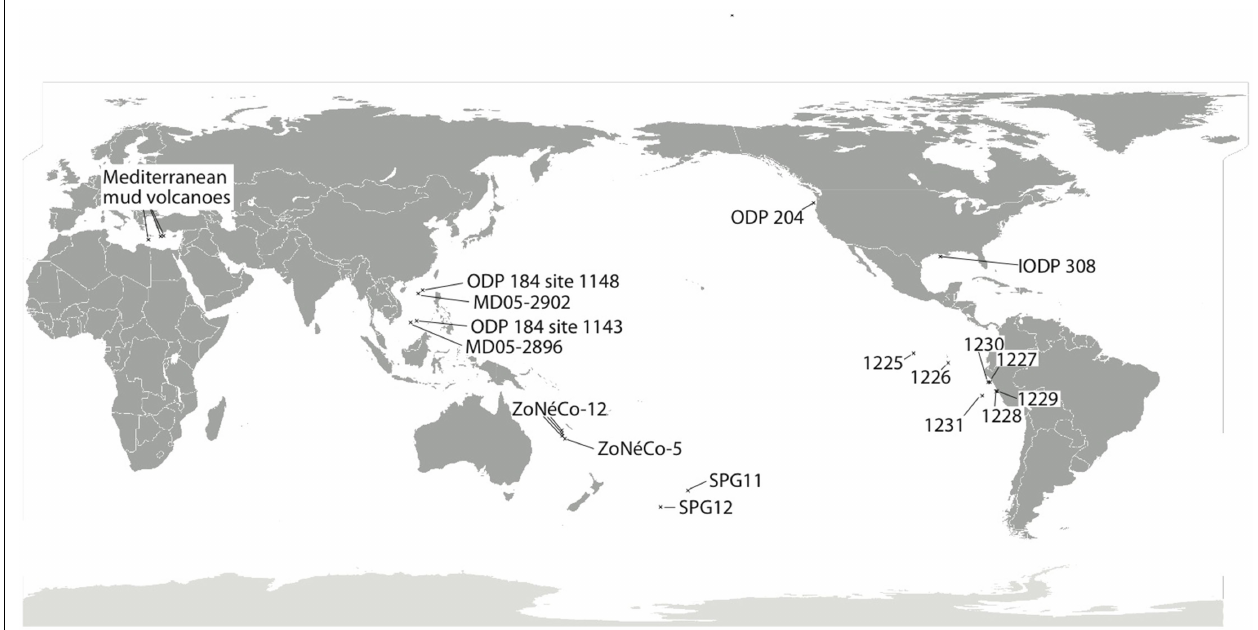
The IODP 308 sites (U1319, U1320) are located in the turbidite depositional Brazos-Trinity Basin on the continental slope of the northern Gulf of Mexico (Nunoura et al., 2009).The ODP Leg 201 Sites (Shipboard Scientific Party, 2003a–f; D’Hondt et al., 2004) include sites from the eastern equatorial upwelling region (1225), South Equatorial Current (1226), Peru Margin (1227, 1229), PeruTrench (1230), and the Peru Basin (1231).The ODP Leg 204 Cascadia Margin sites include sites 1244, 1245, and 1251 (Nunoura et al., 2008). Mud volcano/cold seep sites are represented by three examples from the eastern Mediterranean (Heijs et al.,